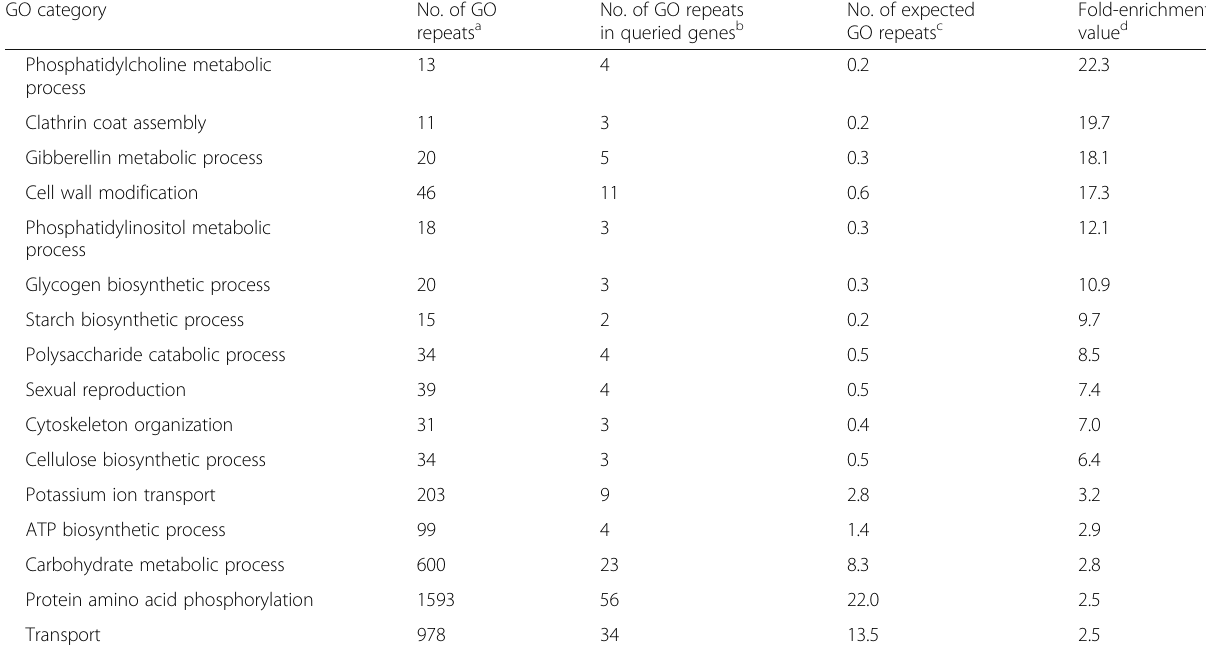
Table 1 Analysis of significantly enriched Gene Ontology terms for genes preferentially expressed in late from rice GO category